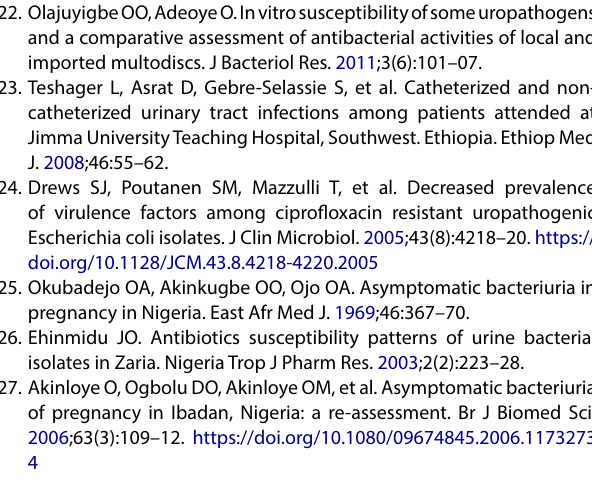
Table 6: Multiple drug resistance pattern of biofilm